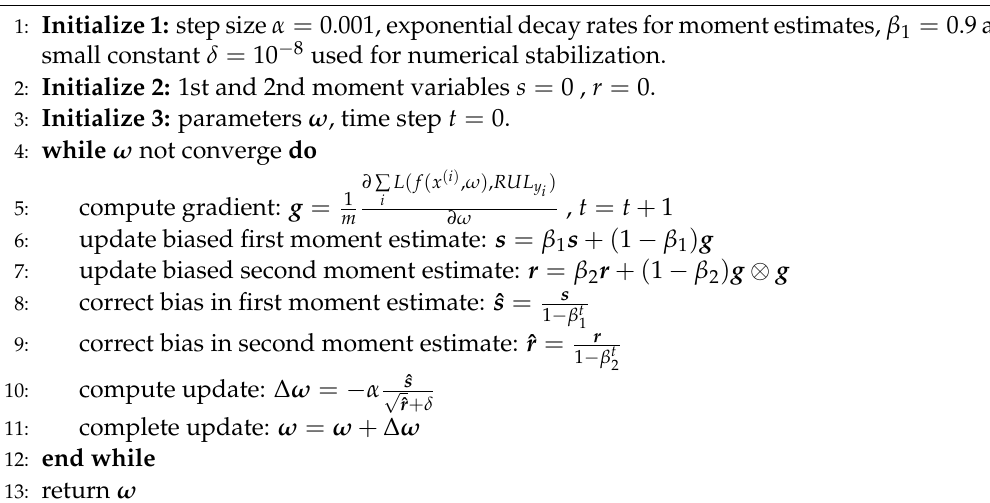
Algorithm 2 Adam optimizer